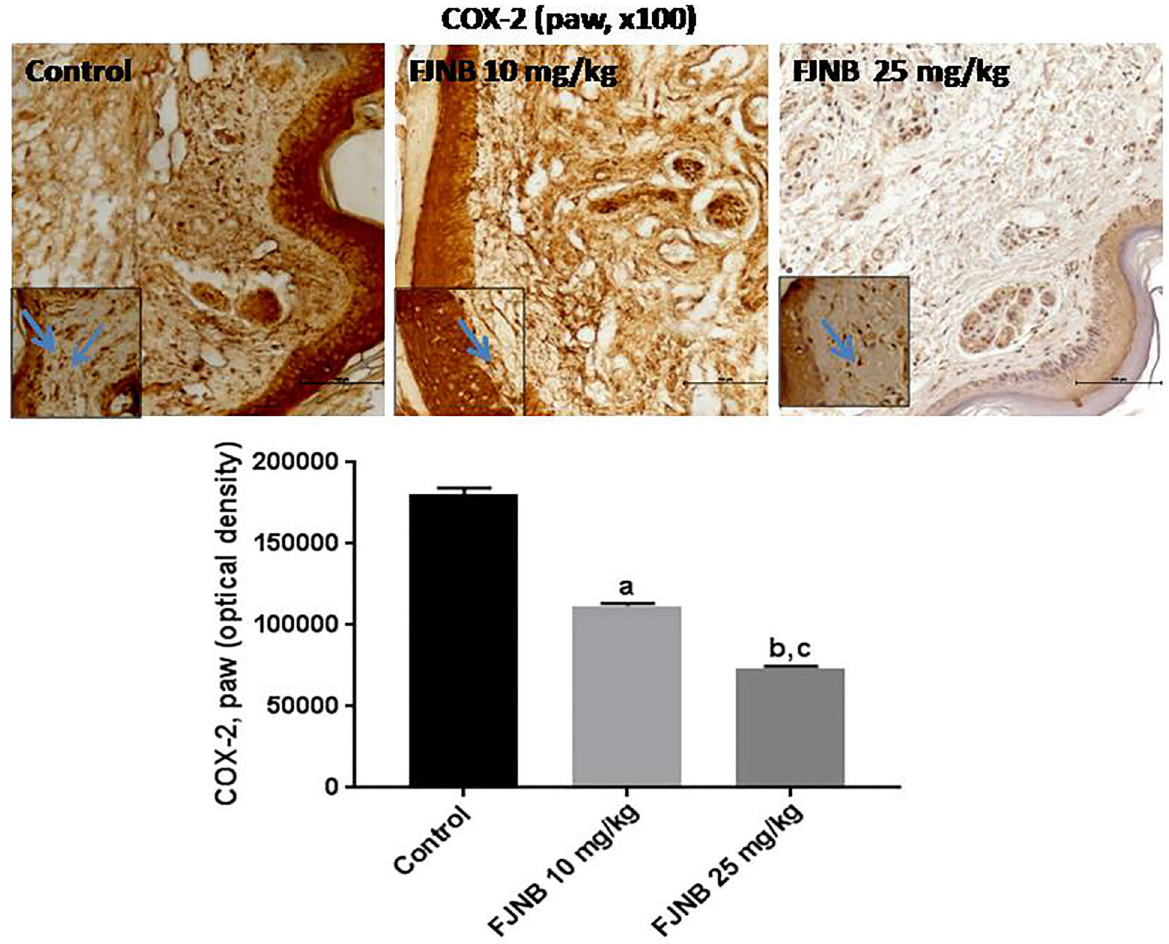
Figure 7 . The triterpene-rich fraction from Himatanthus drasticus (FJNB) inhibits the immunostaining for COX-2 in the in fl amed paws (Controls) from the formalin test, in mice. Representative photomicrographs ( (cid:1) 100 magni fi cation, scale bar, 200 m m). The inserts were taken at (cid:1) 400 magni fi cation and blue arrows show polymorphonuclear cells. Data are reported as means ± SE for 3 different animals. a,b P o 0.0001 vs Control; c P o 0.0001 vs FJNB 10 (one-way ANOVA and Tukey ’ s test for multiple